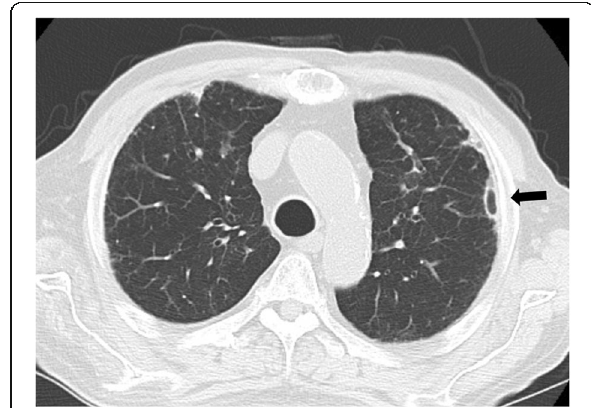
Fig. 2 Chest computed tomography before pneumothorax showing a subpleural nodule with cavitation